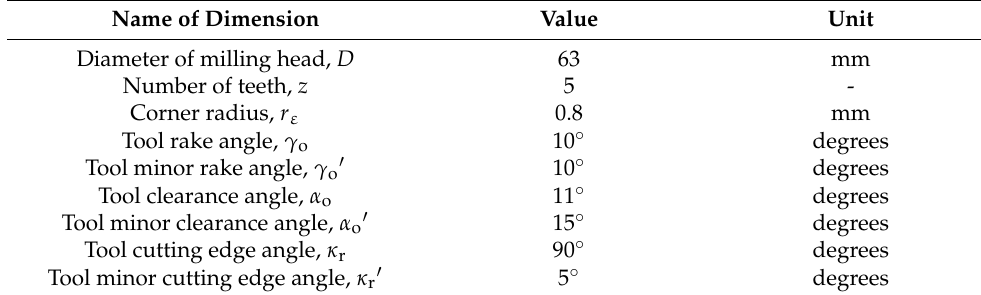
Figure 2. Schematic diagram of the experimental arrangement. Table 2. Basic dimensions of the cutting tool and cutting edge.